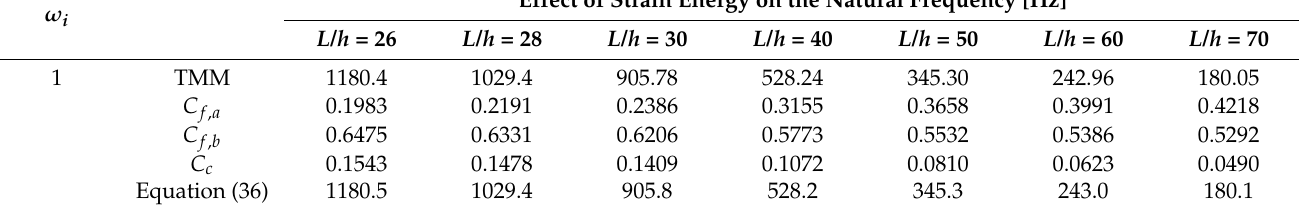
Table 10. Effect of strain energies on the natural frequencies of three-layered beams with the C-C end condition depending on the variation in L/h